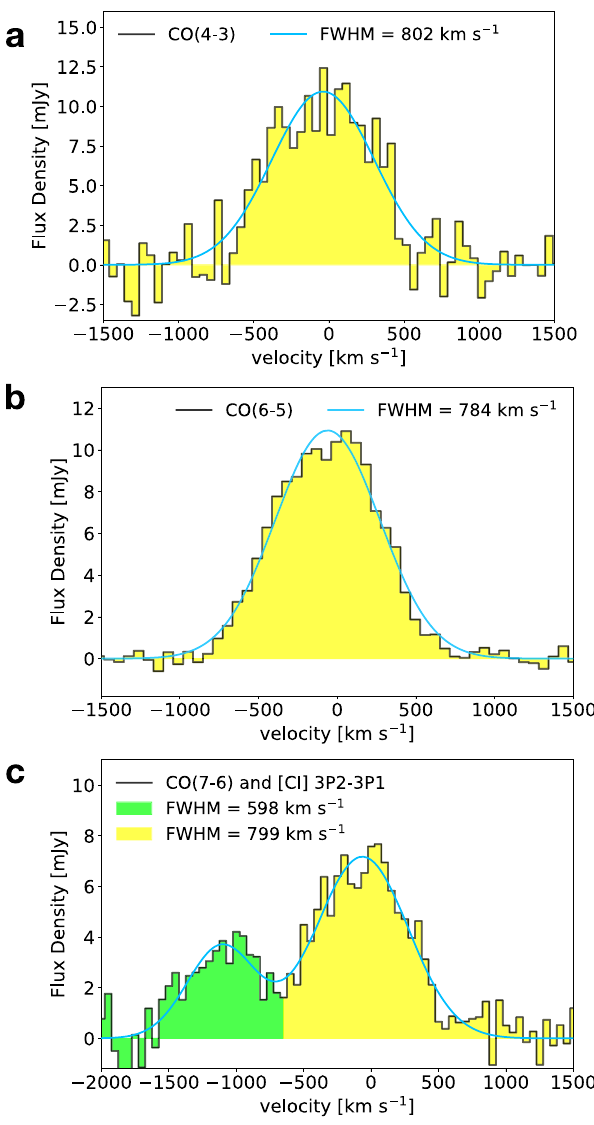
Fig. 8 | ALMA FIR lines observations of the ISM in W0410-0913. a CO(4-3), b CO(6-5),and c CO(7-6)(yellowbars)and[CI](greenbars)spectraofW0410-0913 observedwithALMA.Gaussianmodelsofthelinepro fi